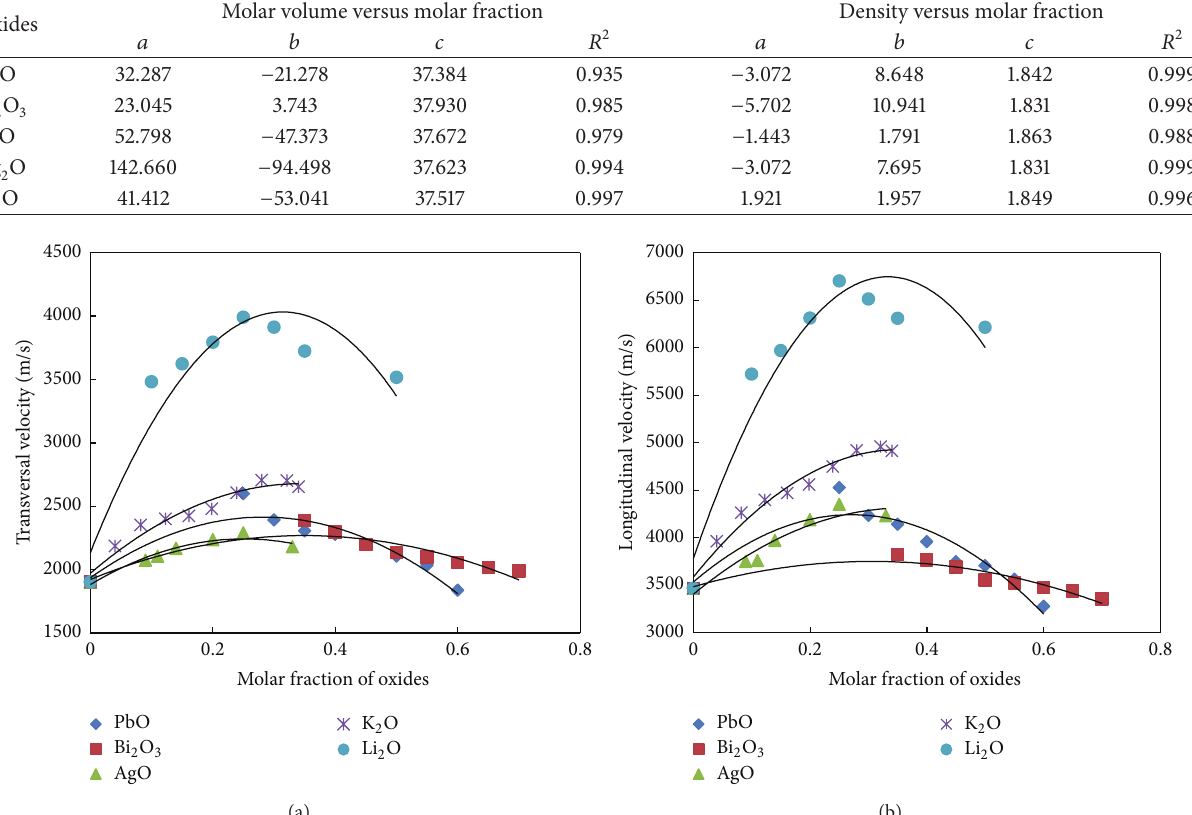
Table 2: Nonlinear regression analysis of the variables ( 𝑦 = 𝑎𝑥 2 + 𝑏𝑥 + 𝑐 ) for density and molar volume in respect to molar fraction of Pb, Bi, K, Ag, and Li oxides [22, 23].